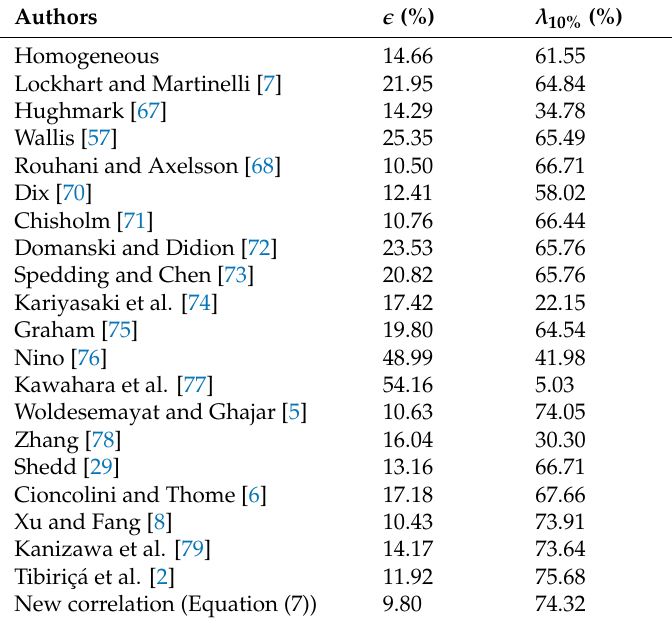
Table 9. Mean absolute error and the percentage of microchannel data with error up to 10% for the correlation